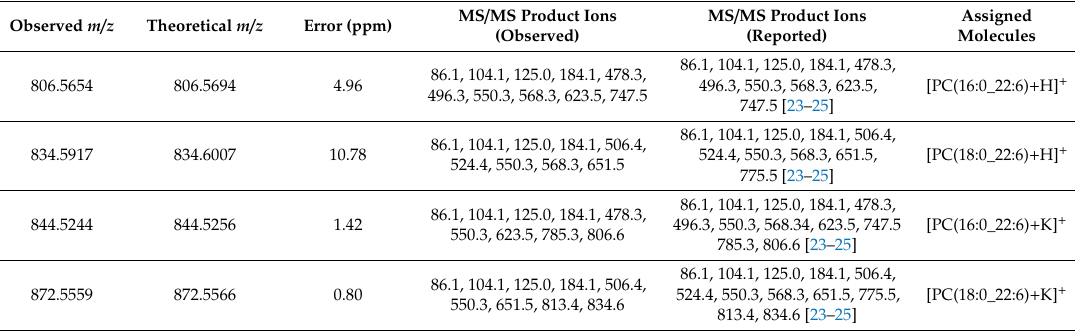
Table 1. List of precursor ions and molecular assignment based on their mass accuracy, LC-ESI-MS / MS product ions and previous